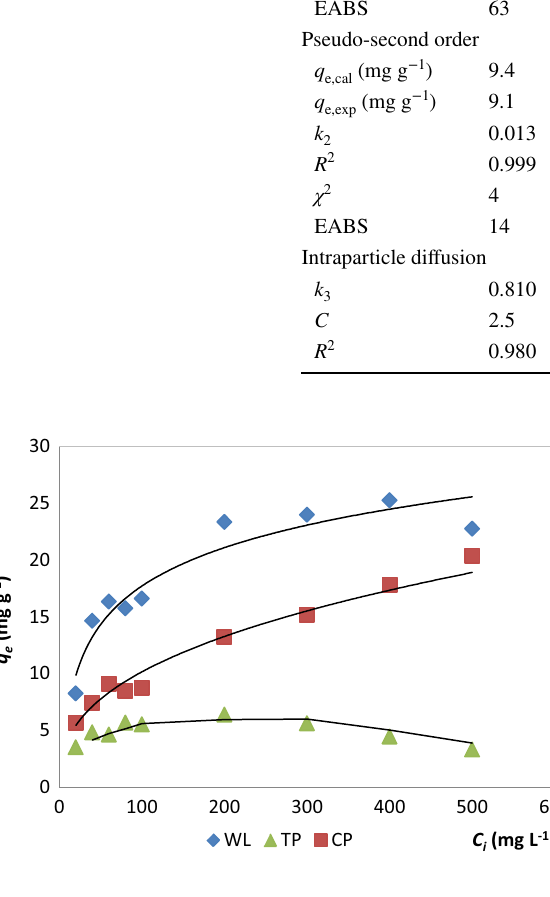
Fig. 5 The effect of AB25 concentration on the adsorption process of WL, TP and